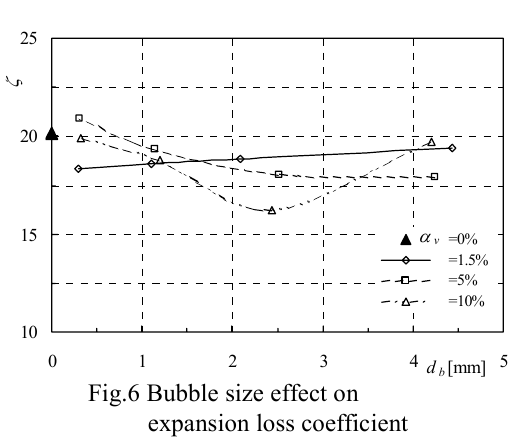
Fig.5 Pressure distribution along surface (bubble size